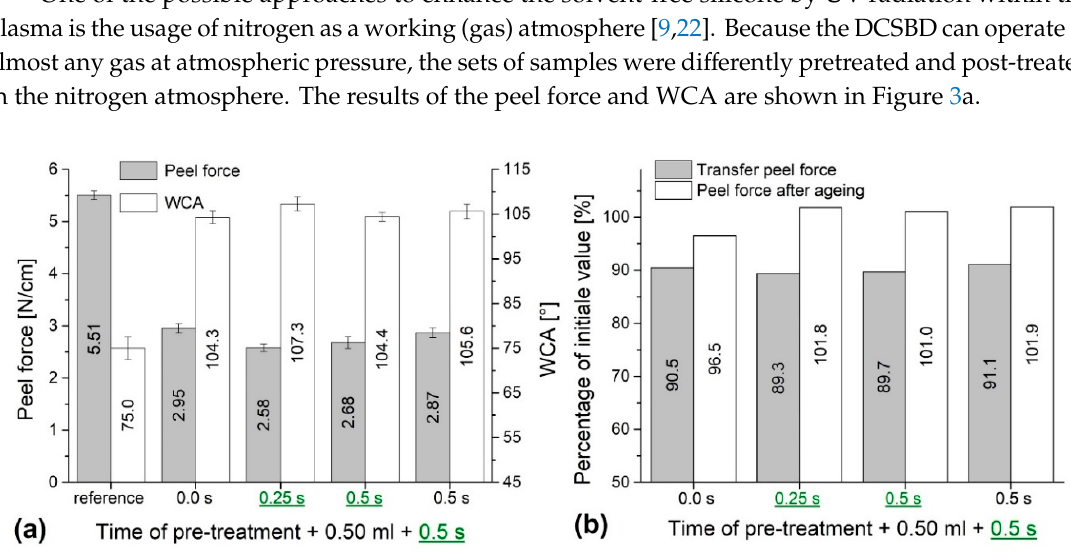
Figure 3. Graphs depicting peel force and WCA values ( a ) and stability and aging of the coating ( b ) measured on silicone-coated paper dependent on the pretreatment time with the post-treatment in nitrogen. The treatment in nitrogen is underlined and labeled by green color.